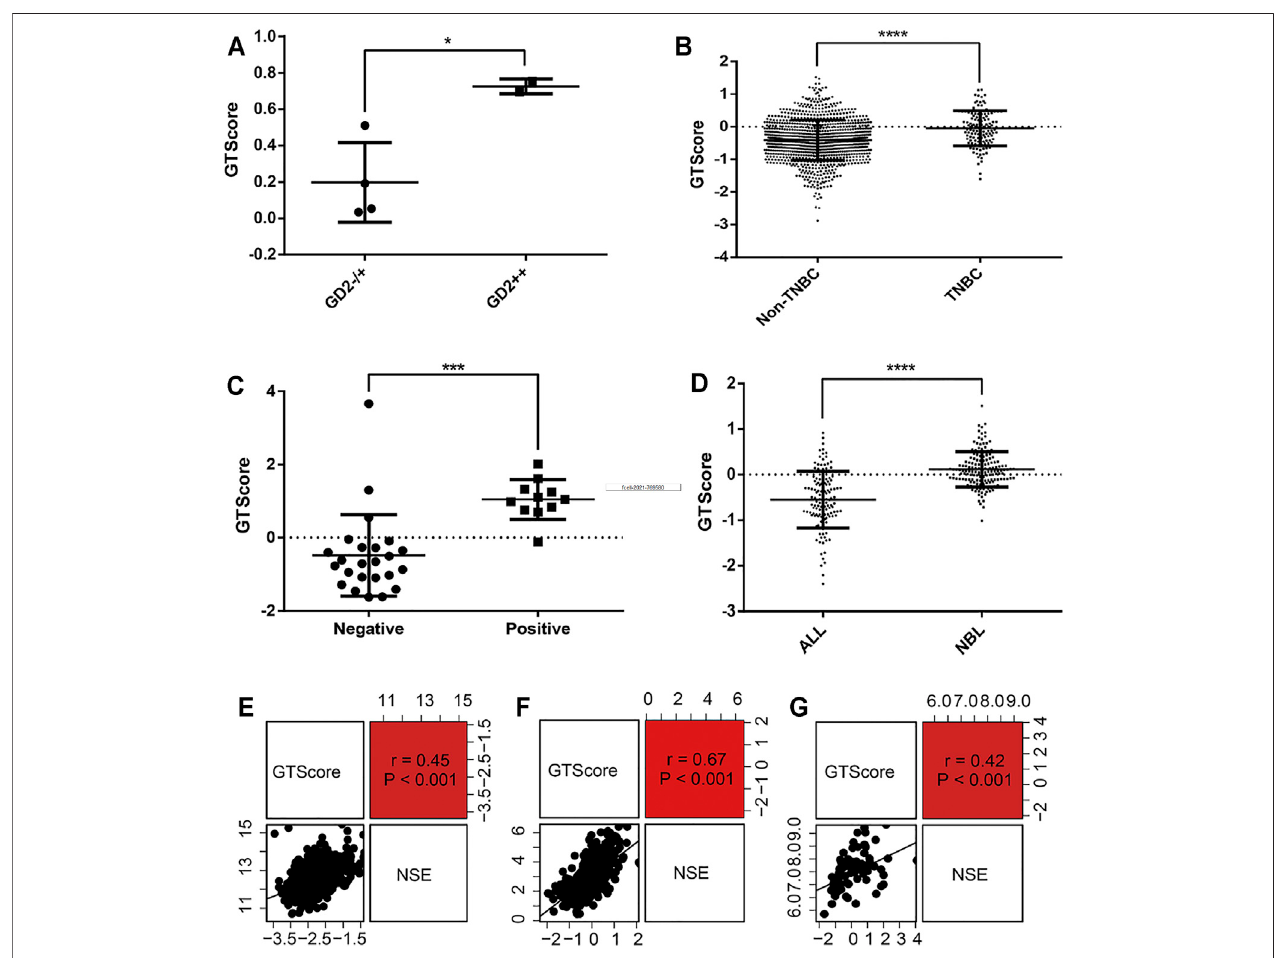
FIGURE 8 | Correlation of GTscore with GD2 phenotype and NSE expression levels. (A) Differences in GTscore between the GD2 ( − ) HOS cell line, GD2 (+) U2OS cell line, U-373 cell line, SH-SY5Y cell line, and GD2 (++) T98G and IMR-32 cell lines. (B) Differences in GTscore between GD2 ( − ) non-TNBC and GD2 (+) TNBC samples. (C) DifferencesinGTscorebetweenGD2(+)andGD2( − )NBsamples. (D) DifferencesinGTscorebetweenGD2( − )ALLandGD2(+)NBsamples.Scatterplots showing the correlations between GTscore and NSE expression levels in NB (E) , melanoma (F) , and small cell lung cancer (G) samples. * p < 0.05, *** p < 0.001, **** p <